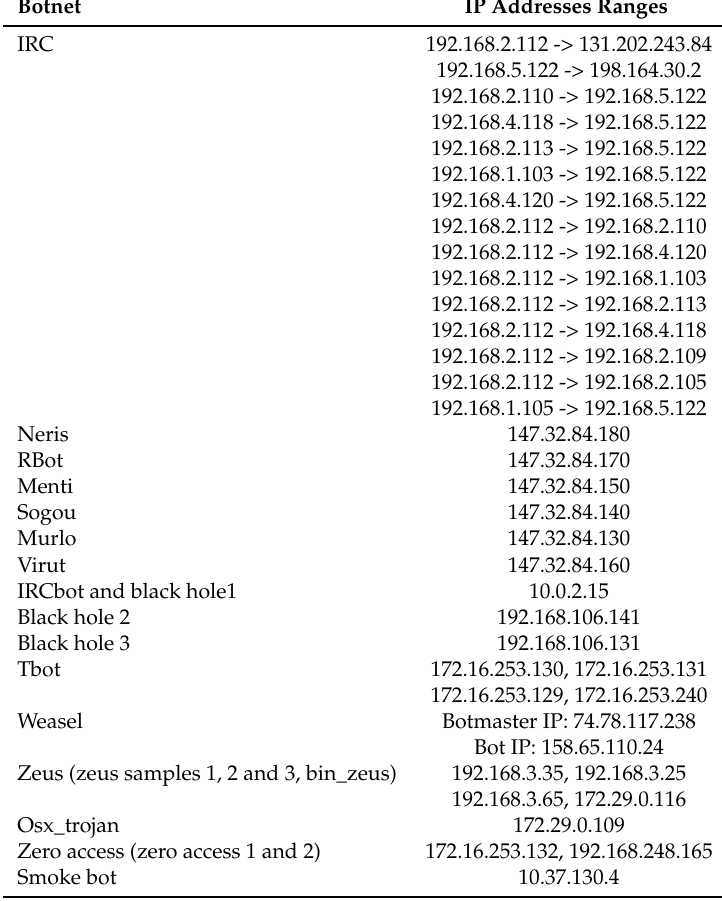
Table 2. List of malicious IPs on ISCX-Bot-2014 dataset.